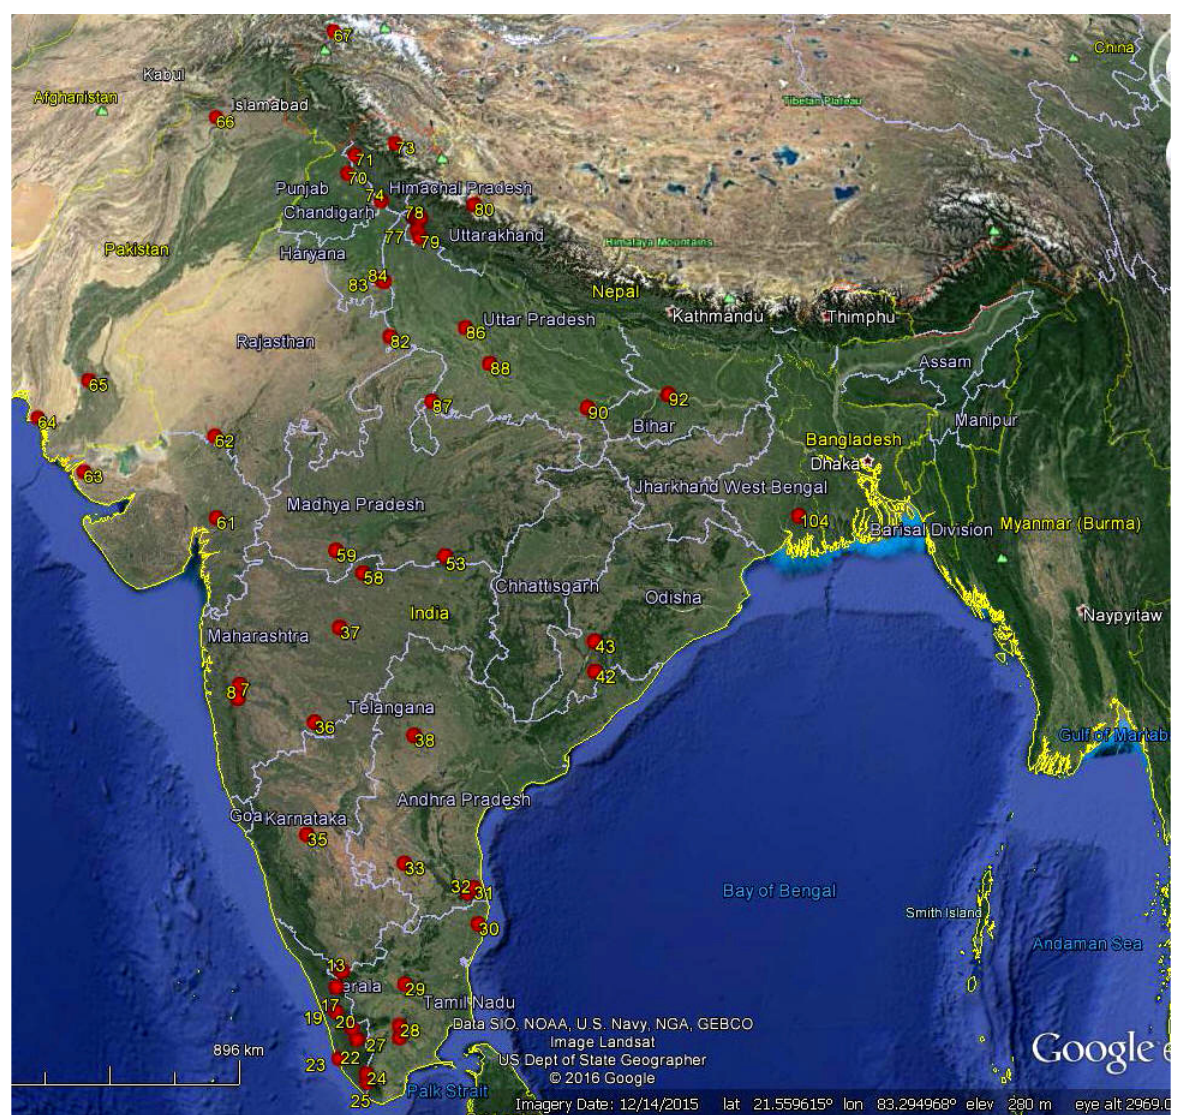
Figure 2b. Records of absence of Euthalia